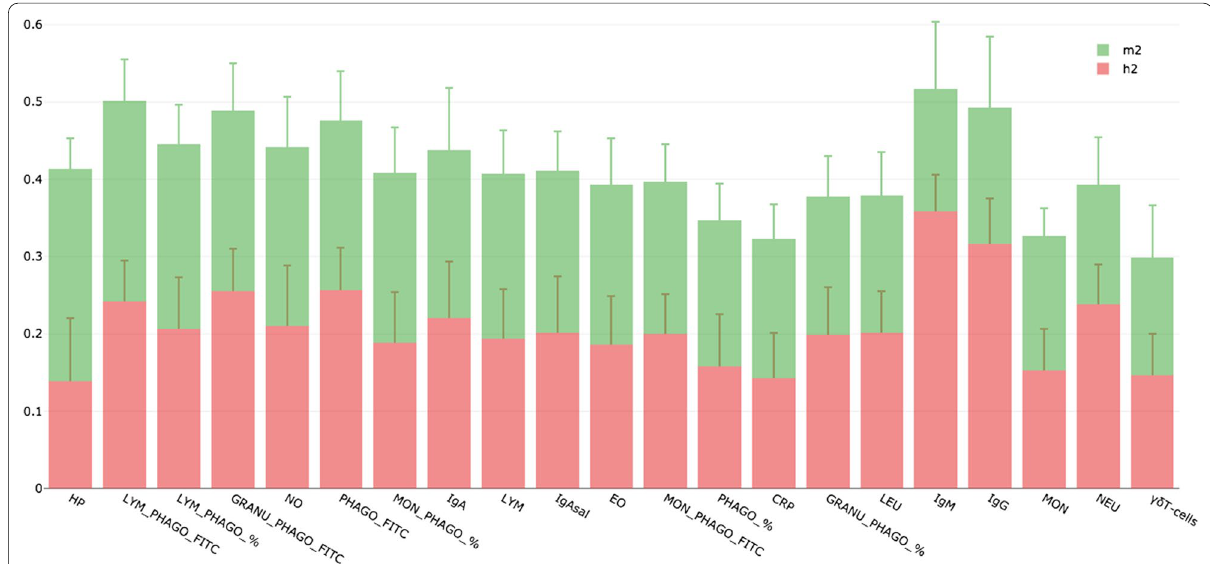
Fig. 1 Percentage of phenotypic variance explained by the host‑genetic (red points) and the gut microbial composition (green points) for most relevant immunity